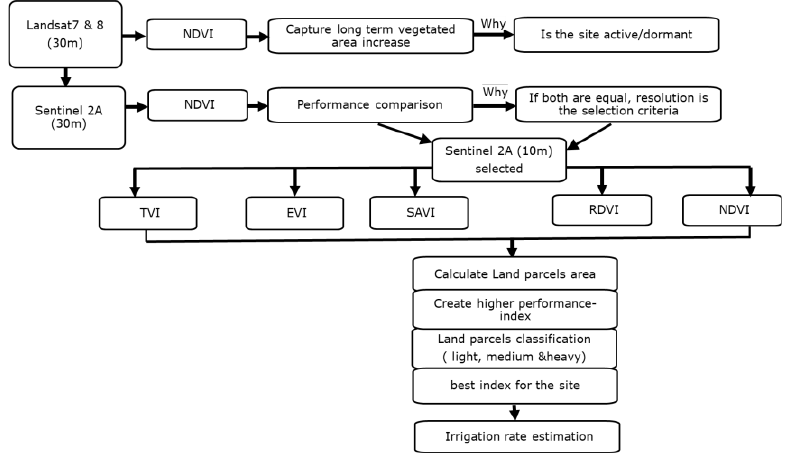
Figure 2. The used technique and data to roughly estimate the irrigation rate at the study site.